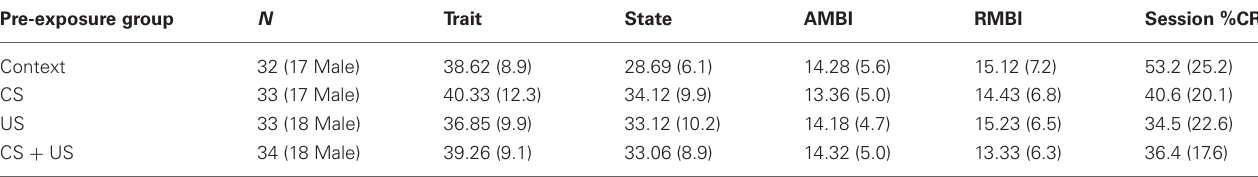
Table 1 | Psychometric and demographic data groups Context, CS pre-exposure, US pre-exposure, and CS + US pre-exposure. Pre-exposure group